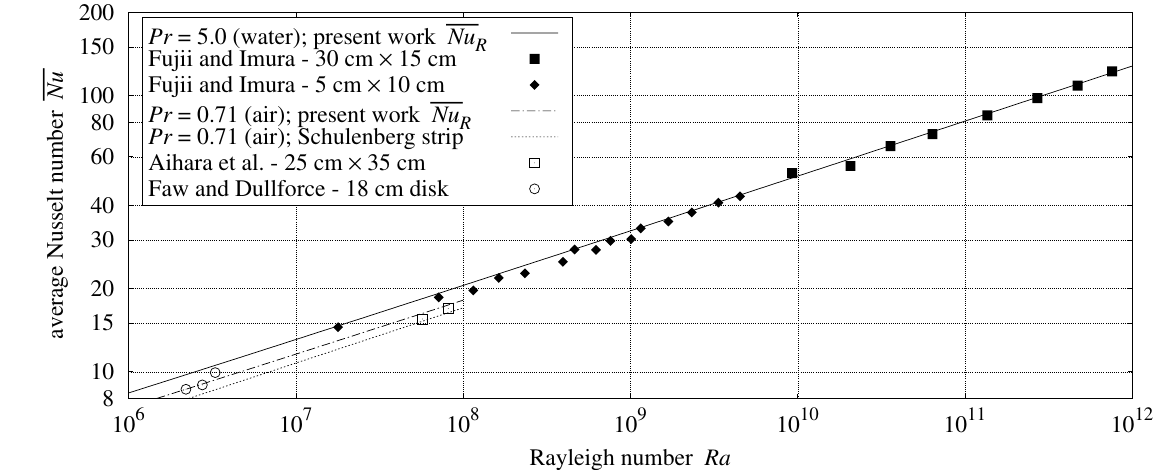
Figure 6 and Table 7 present the four downward-facing data-sets.